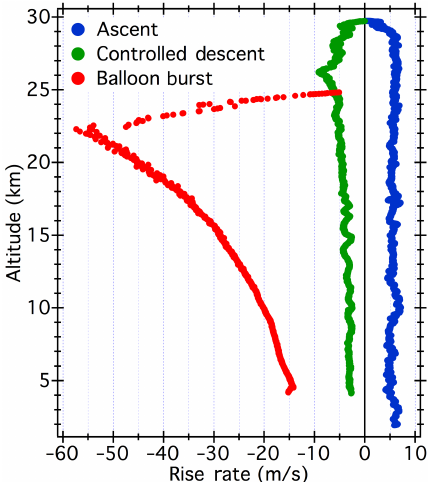
Figure 1. Typical balloon vertical velocities during ascent (blue) followed by controlled descent using the automatic valve method (green) or descent after balloon burst (red). The ascent profile shows the valve opened at 28.5km, first reducing the ascent rate to zero (float) then establishing a slow and fairly steady descent rate < 10ms − 1 (green). The red profile indicates the balloon burst prematurely at 25km, prior to activation of the valve. The de- scent rate after burst initially exceeded 50ms − 1 then was gradually slowed to < 20ms − 1 by the parachute. For both descent profiles reception of the radiosonde telemetry signal was lost at ∼